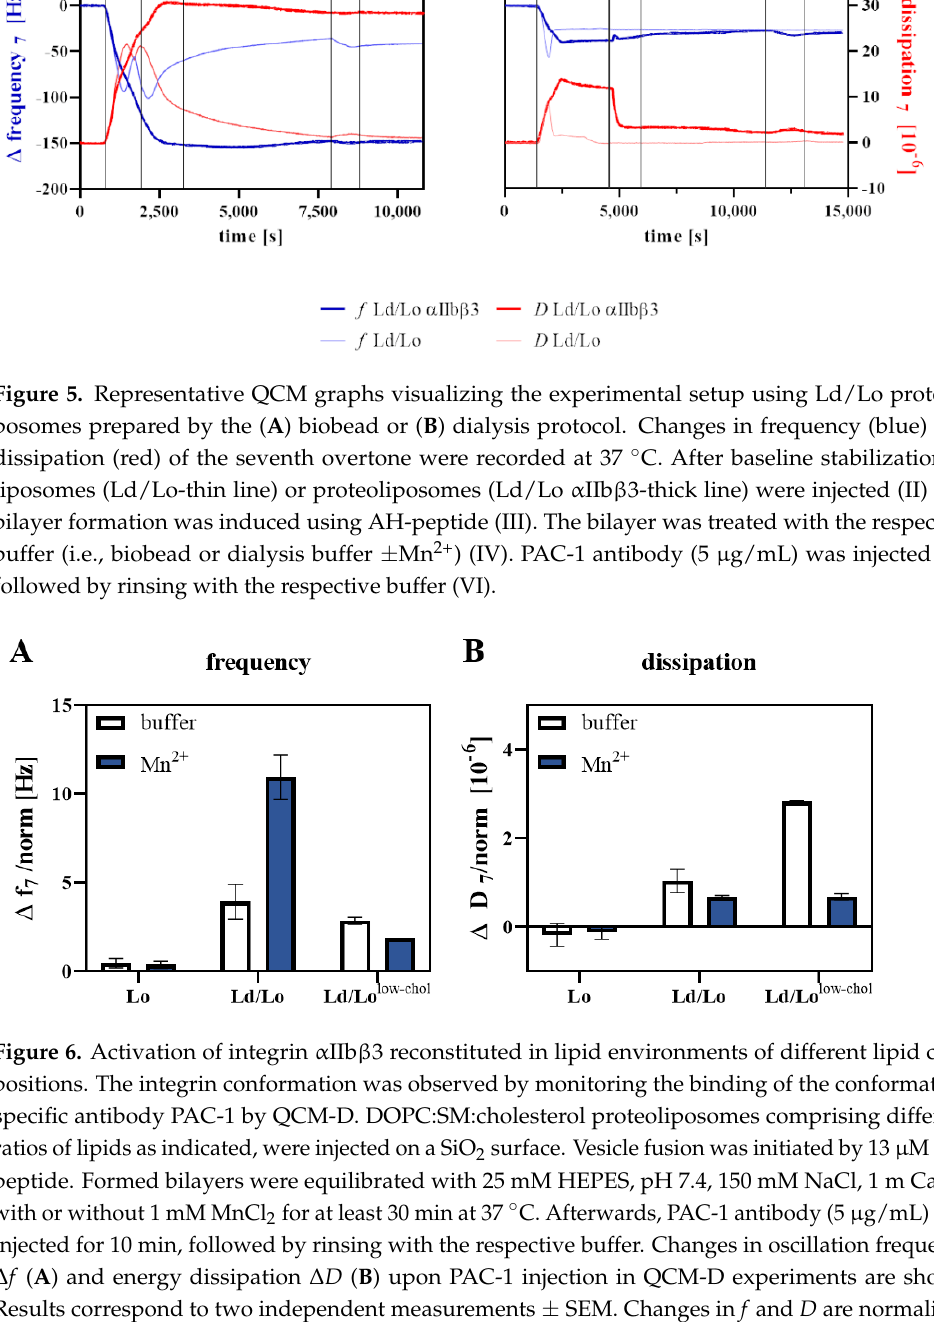
Figure 5. Representative QCM graphs visualizing the experimental setup using Ld/Lo proteolipo- somes prepared by the ( A ) biobead or ( B ) dialysis protocol. Changes in frequency (blue) and dissi- pation (red) of the seventh overtone were recorded at 37 °C. After baseline stabilization (I) lipo- somes (Ld/Lo - thin line) or proteoliposomes (Ld/Lo αIIbβ3- thick line) were injected (II) and bilayer formation was induced using AH-peptide (III). The bilayer was treated with the respective buffer (i.e., biobead or dialysis buffer ±Mn 2+ ) (IV). PAC-1 antibody (5 µg/mL) was injected (V), followed by rinsing with the respective buffer (VI).